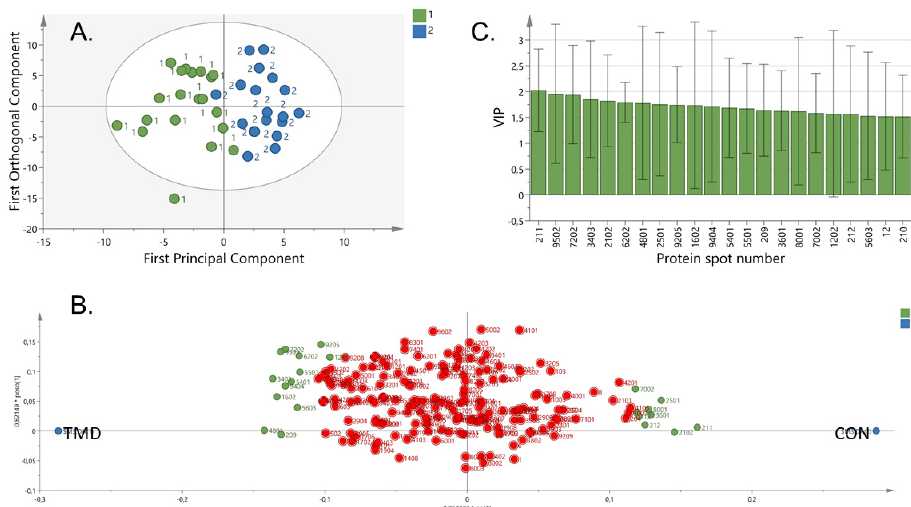
Figure 1. Multivariate analysis. Graphs showing proteins that di ff ered between 20 patients with temporomandibular disorders (TMD) myalgia and 20 age- and sex-matched controls (CON). ( A ). orthogonal partial least-square discriminant analysis models showing separation between patients with TMD (green circle marked as number 1) and healthy controls (blue circle marked as 2). The longitudinal dimension (y-axis) shows the interclass discrimination, and the latitudinal dimension (x-axis) shows the intraclass discrimination between the groups. ( B ). Loading score highlighting proteins of importance for the separation. Green circles refer to proteins with variable importance of projection (VIP) > 1.5. Proteins on the right are positively associated with CON, and those on the left are positively associated with TMD. ( C ). VIP values for proteins. VIP values > 1.5 were considered significant. Protein spot numbers 211 and 9502 were the most important proteins for group separation (TMD vs. CON). Table 2. Proteins altered in the saliva from patients compared to controls. Identified salivary proteins that were altered in patients (Pat) with temporomandibular disorder myalgia compared to healthy controls (Con). Proteins with a VIP above 1.5 in the orthogonal partial least-squares discriminant analysis model are shown. The p -value is according to the Mann–Whitney data analysis. Arrows ↑ and ↓ indicate up- and downregulated proteins in patients compared to controls.